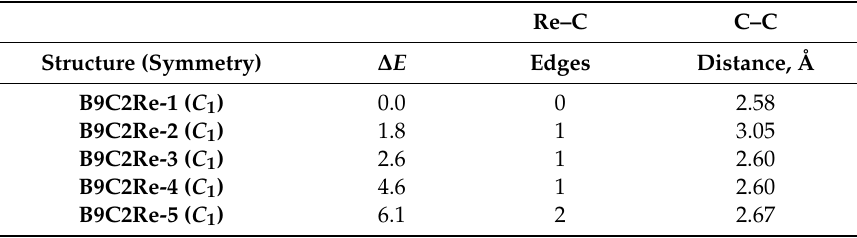
Figure 7. The five optimized lowest energy 12-vertex C 2 B 9 H 11 Re(CO) 2 (NO) structures. Table 5. The five optimized 12-vertex C 2 B 9 H 11 Re(CO) 2 (NO) structures within 15 kcal / mol of the lowest energy structure. All of these structures have central C 2 B 9 Re icosahedra with exclusively degree 5 vertices.